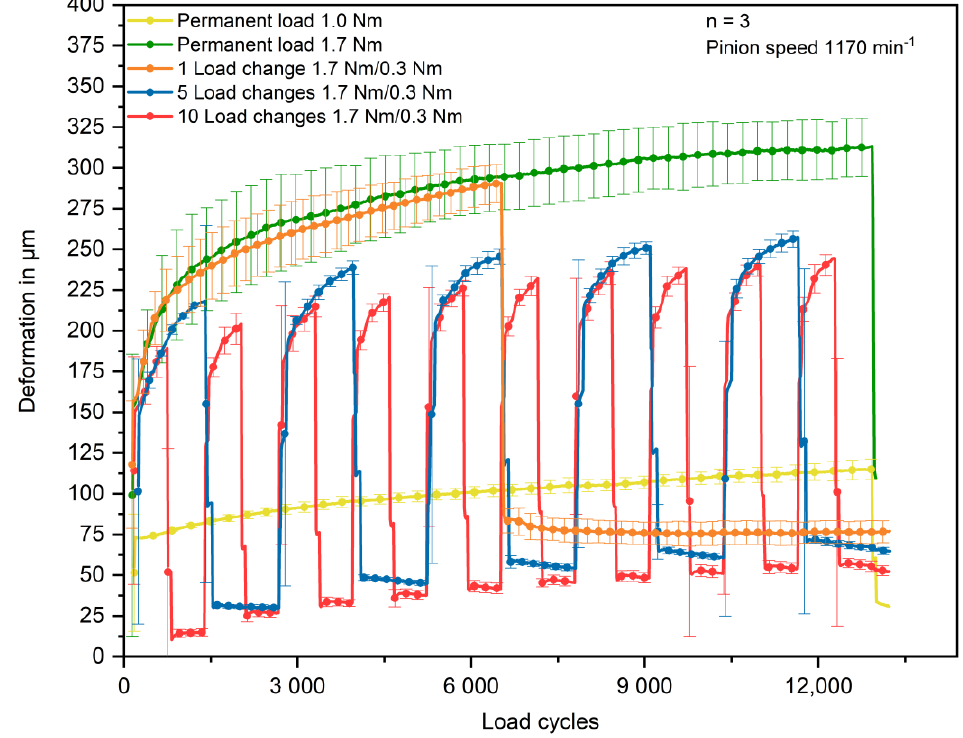
Figure 7. In situ measured gear wear in dependence of the applied load spectrum.